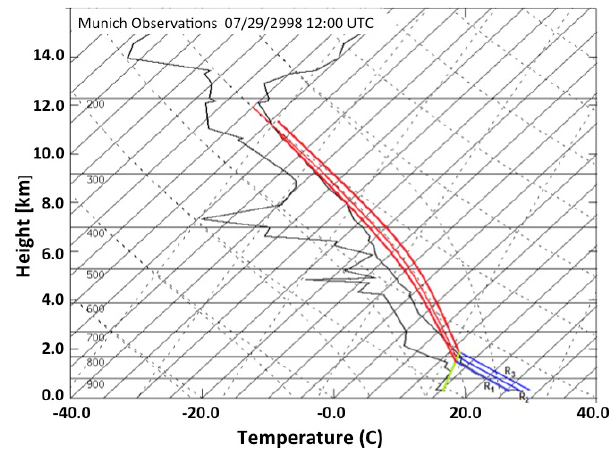
Fig. 2. Skew-T diagram showing how different initialization pro- files for the EMTM model can be generated by means of different temperature perturbations below cloud base. The black curves are taken from a continental summer sounding and represent the basic state of the atmosphere. The blue curves (R1, R2, and R3) are three different dry adiabatic thermal perturbations, the green line repre- sents the moisture of the thermal bubble and the three red curves represent the moist adiabatic profiles corresponding to the three dif- ferent thermal